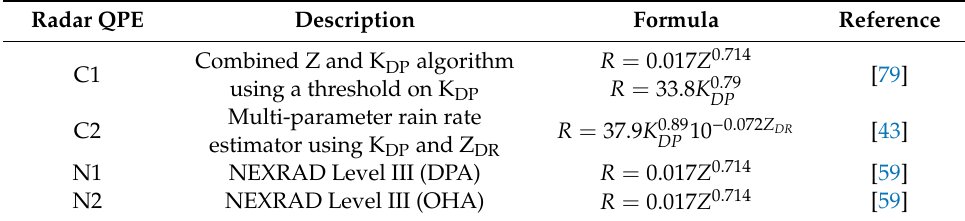
Table 1. List of rain-rate estimators for radar Quantitative Precipitation Estimates